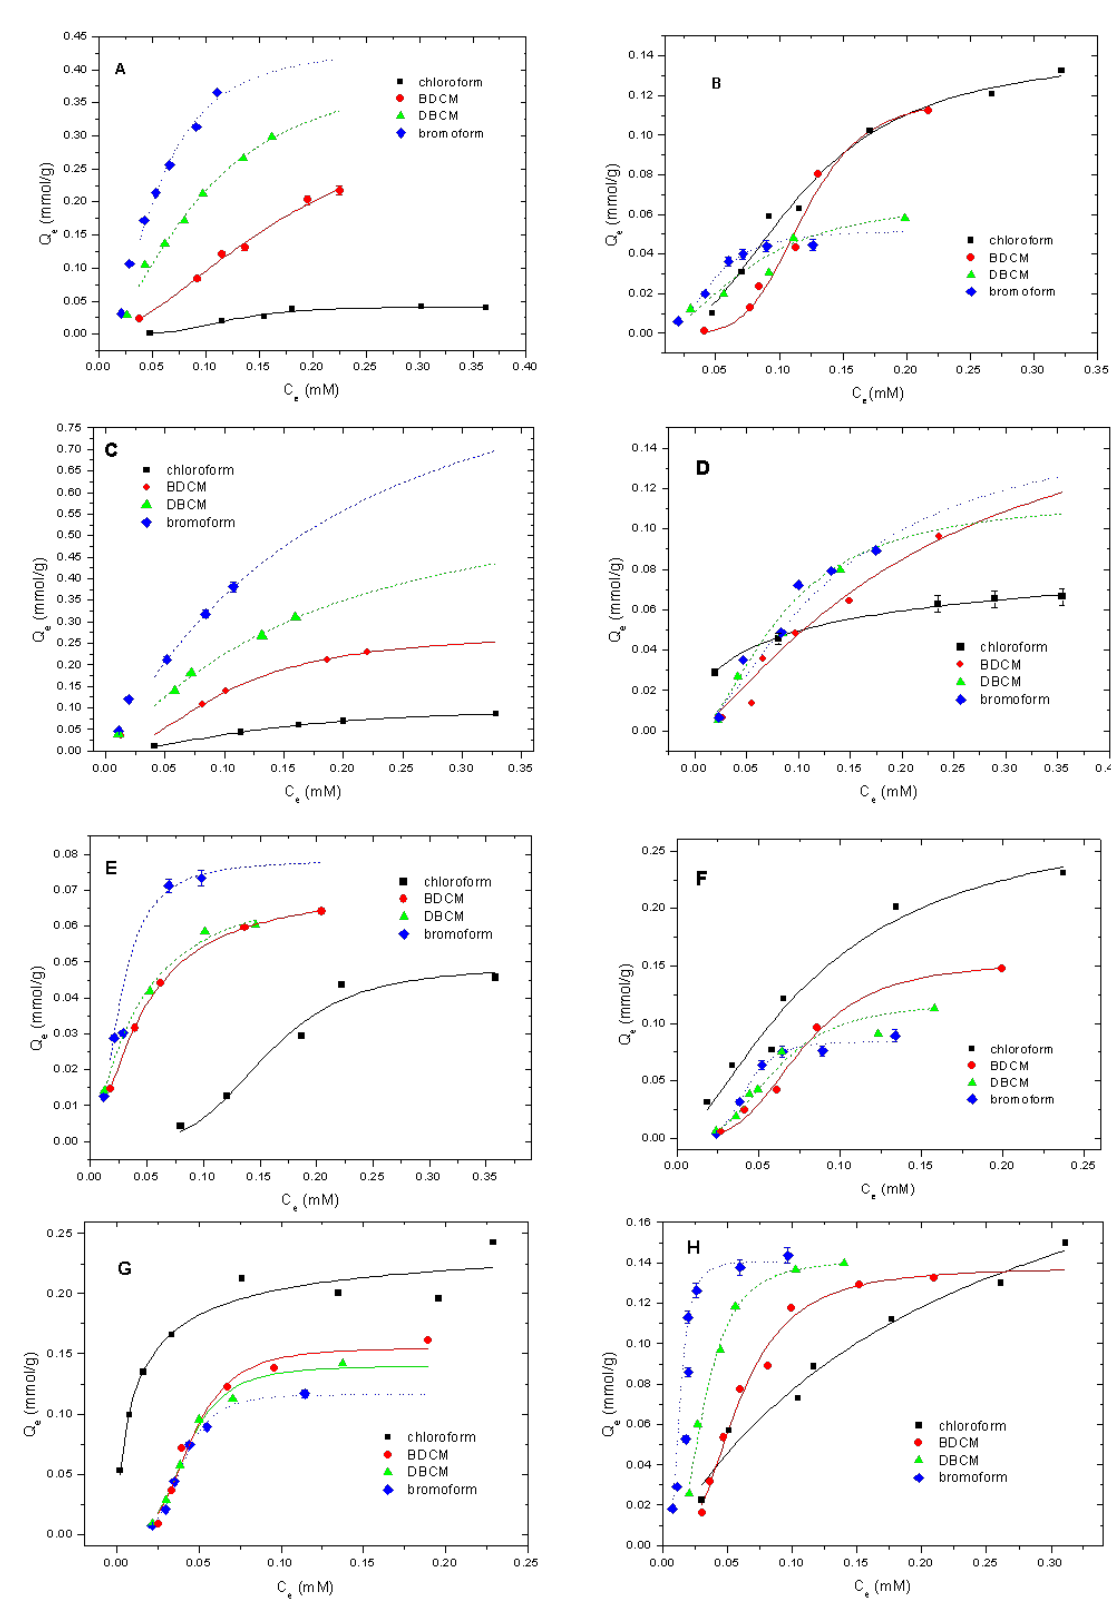
Figure 3. Adsorption isotherms for various copolymers with THMs at pH 6.5 and 295 K: ( A ) CP-1, ( B ) CP-5, ( C ) β -CD/PAA 1:5, ( D ) β -CD /PAA 1:5 at high speed, ( E ) β -CD/PAA 1:10, (F ) SCl-5, ( G ) SCl-10, and ( H ) AC. The best-fit results were obtained by the Sips isotherm model ( cf . Equation (3)), as shown by the fitted lines through the isotherm data.